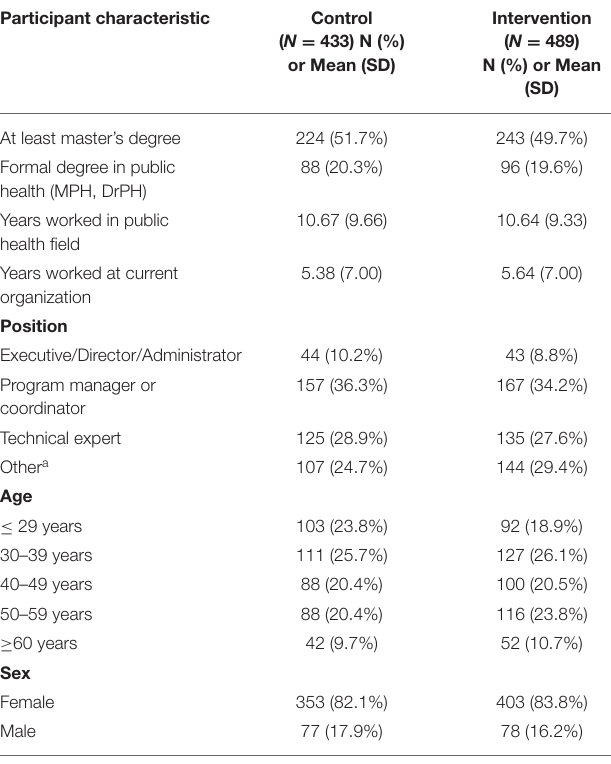
TABLE 2 | Sample characteristics at individual level by trial mode. TABLE 3 | Outcome measures by trial